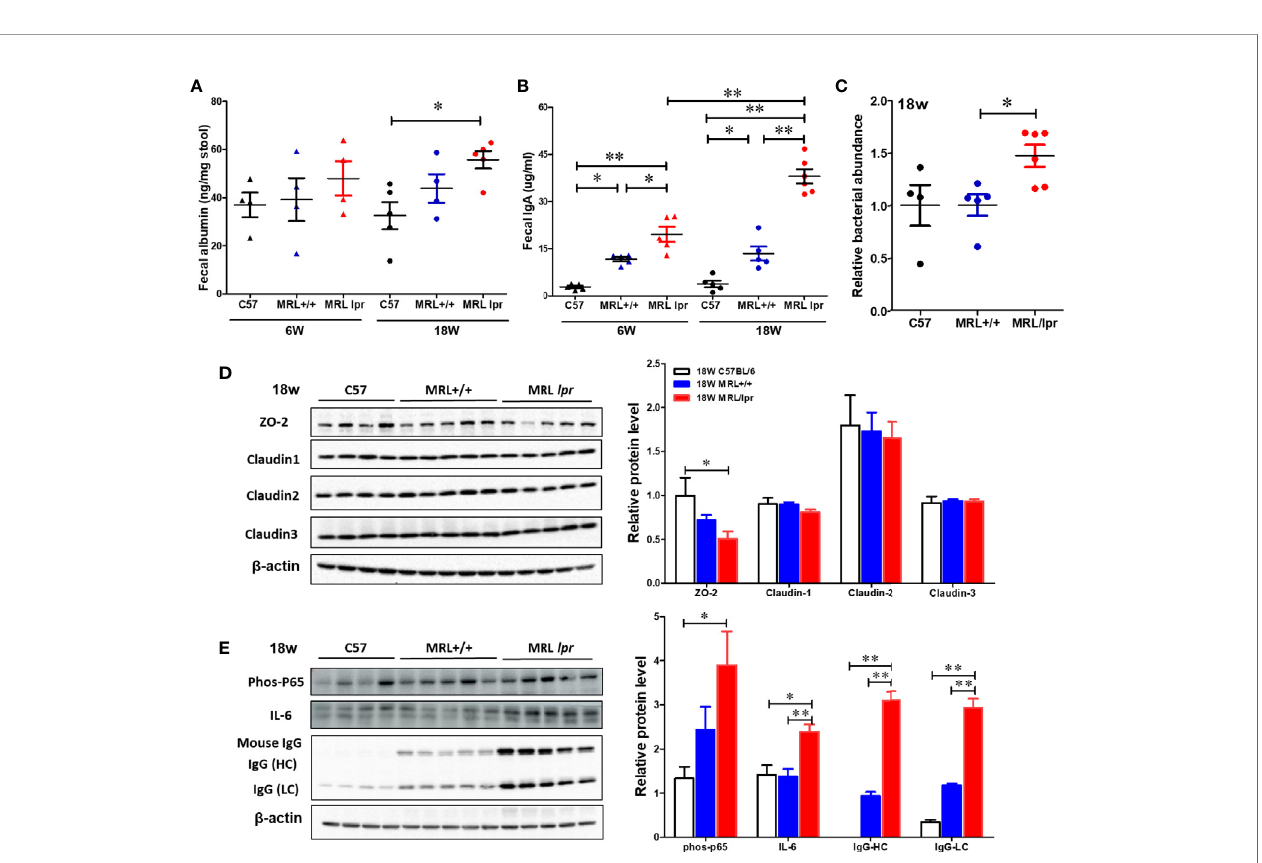
FIGURE 6 | Impaired gut barrier in lupus-prone mice. Fecal albumin and IgA levels were determined by ELISA. Liver DNA was extracted and RT-PCR was performed with Eubacteria primer to detect the bacterial translocation. Colon protein samples were subjected to SDS-PAGE and blotted with speci fi c antibodies. (A) Fecal albumin levels. (B) Fecal IgA levels (C) Bacterial translocation to liver (D, E) Western blot for tight junction proteins (ZO-2, Claudin 1-3) and in fl ammatory markers. Results are mean ± SEM. n = 4 * p < 0.05; ** p <